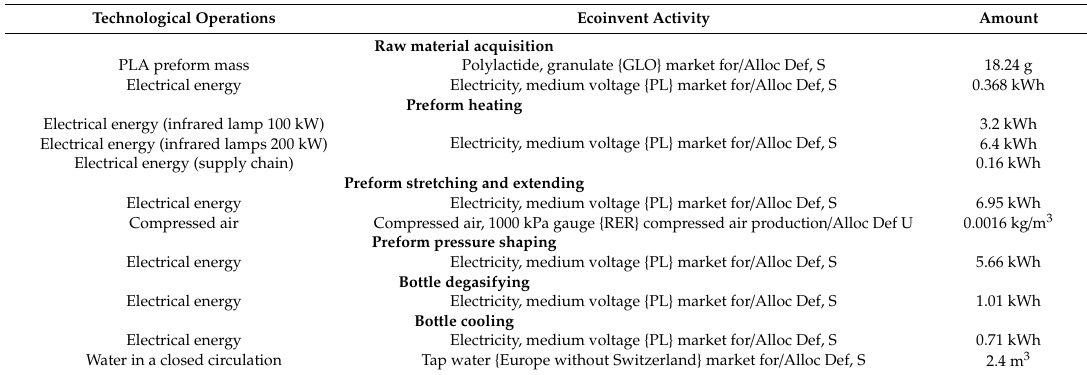
Table 4. Results LCI